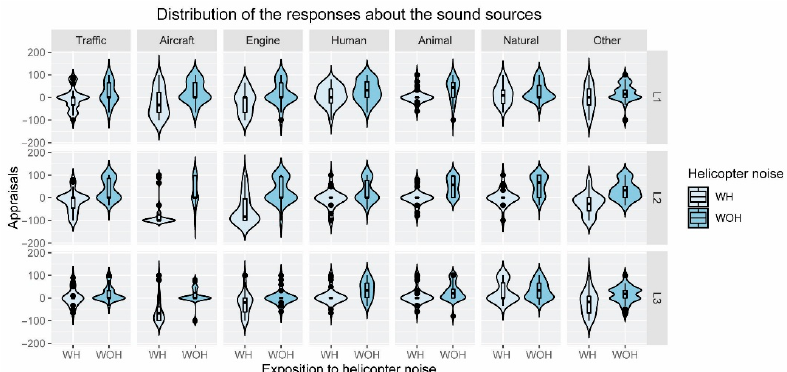
Figure 3. Violin plot of the responses given to the pleasantness of the sound source categories for the three locations under study (L1, L2, and L3), split into two acoustic conditions, with (WH) and without helicopter noise (WOH).